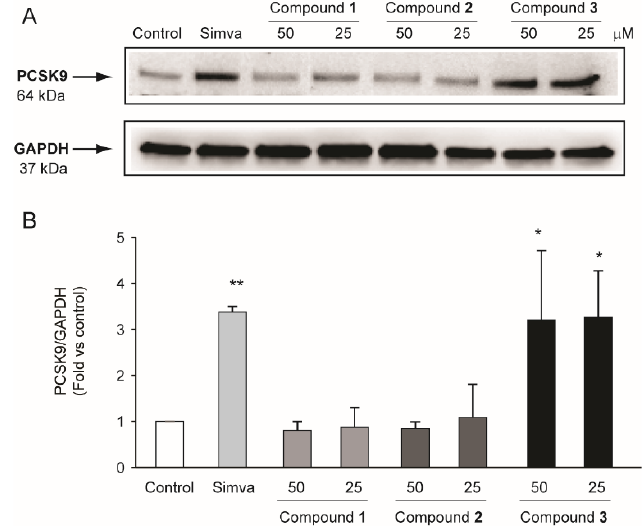
Figure 6. Effect of compounds 1 – 3 isolated from R. michauxii on PCSK9 expression in the Huh7 cell line. Cells were incubated with MEM/10% FCS in the presence or absence of indicated concentrations of compounds and 2.5 µM simvastatin (simva). After 72 h, total protein extracts were prepared and PCSK9 expression evaluated by western blot analysis. GAPDH was used as a loading control. ( A ) representative images of three independent experiments. ( B ) densitometric readings were evaluated using ImageLab TM software. Each bar represents the mean ± SD of three independent experiments. * p < 0.05; ** p < 0.01 vs. control.